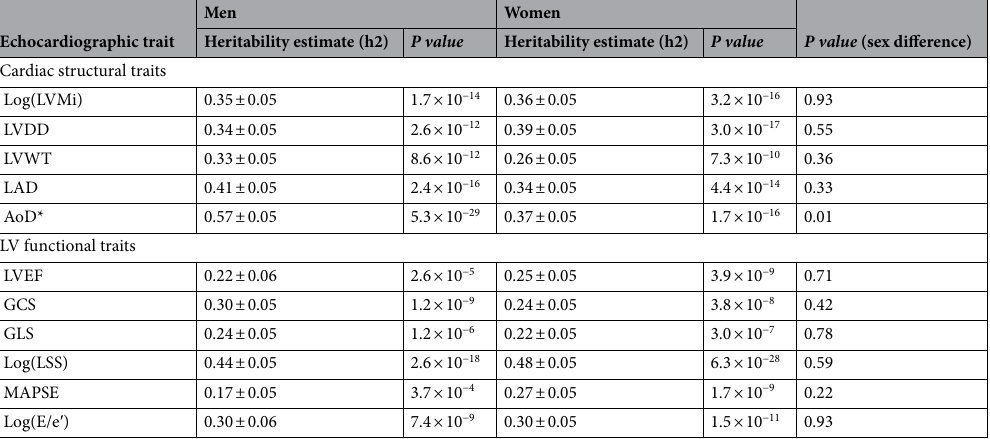
Table 1. Sex-specific heritability estimates. *Heritability of AoD is higher in men compared to women ( P = 0.01).